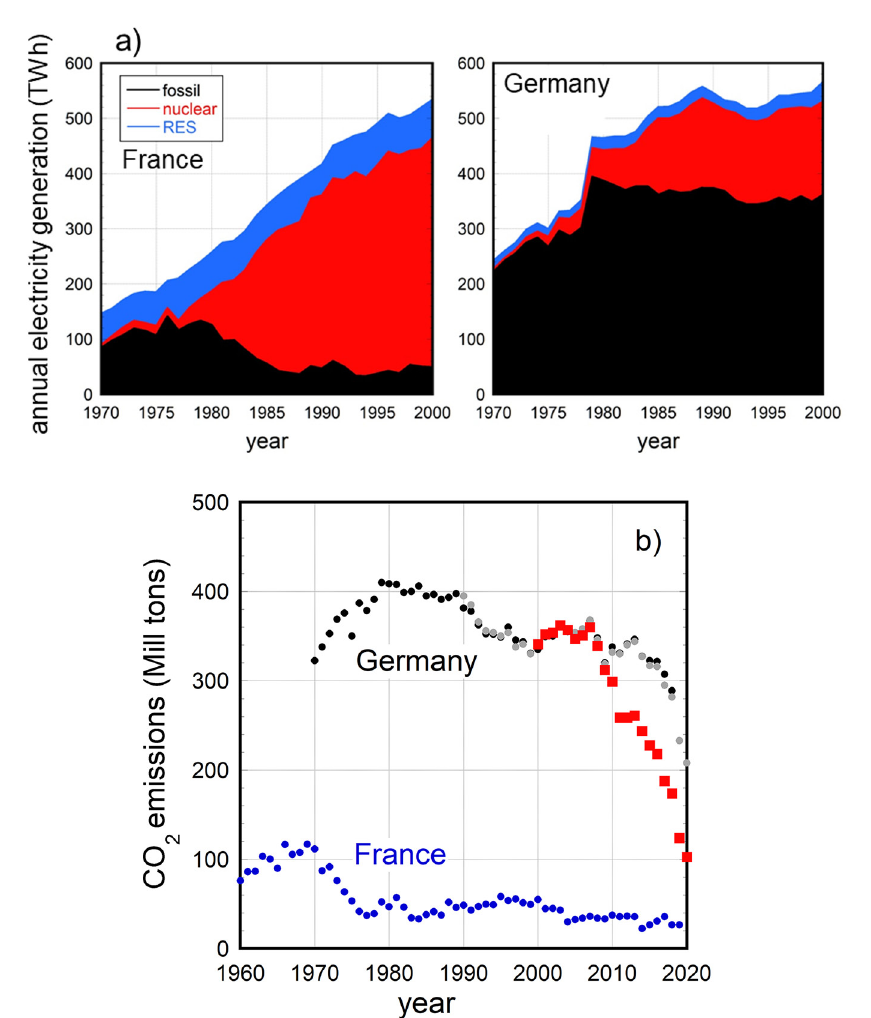
Fig. 12. – (a) Annual electricity generation of France and Germany from 1970 to 2000 split up into fossil, nuclear and RES shares. (b) CO 2 emission from electricity generation of France and Germany starting from 1960 or 1970, respectively. Data sources: black and blue: EDGAR- EU [24]; the grey dots represent emission data averaged from UBA [25] and STATISTA [26] compilations. The red squares represent Germany’s CO 2 emissions in case nuclear energy had remained at the year 2000-level and lignite had been reduced in the following years in the steps nuclear energy was removed from the